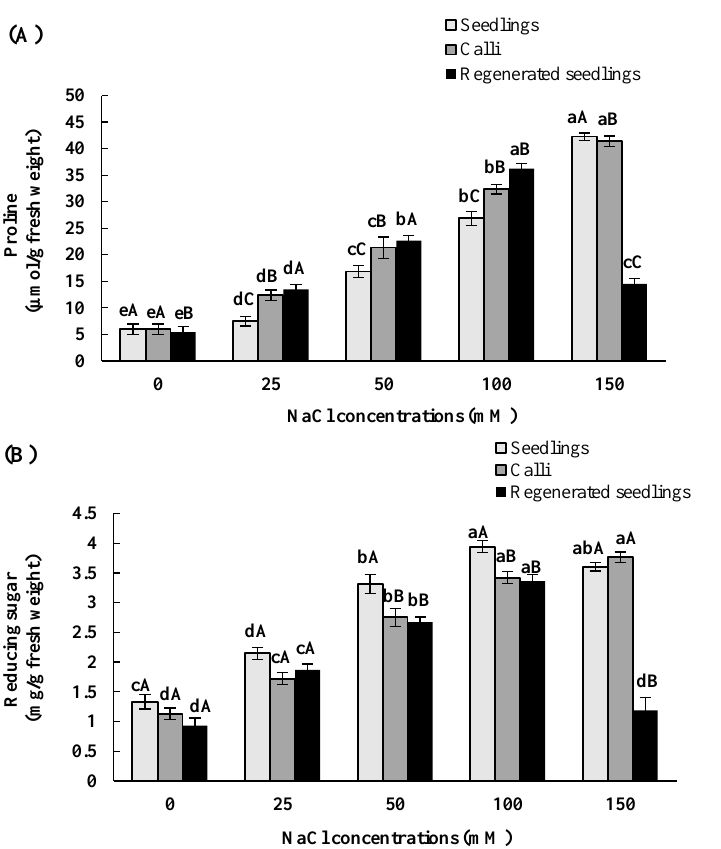
Figure 4. Effect of salinity on compatible osmolytes of Carum copticum. Mature sterilized seeds and regenerated seedlings were grown on MS medium containing 0, 25, 50, 100, and 150 mM NaCl. Calli were cultured on MS medium containing 1 mg L −1 BAP, 0.25 mg L −1 2,4-D, and the above-mentioned concentrations of NaCl. The amount of proline ( A ) and reducing sugars ( B ) were measured using four-week shoots of salt treatment. Values represent the mean of three replicates with error bars indicating ± standard errors. Different lowercase letters indicate significant differences among the 5 NaCl concentrations in an explant of Carum copticum, and different uppercase letters indicate significant differences among 3 explants of Carum copticum within the same NaCl level according to Duncan’s test p ≤ 0.05. Table 6. Comparison of proline and reducing sugar contents in three explants of Carum copticum under five NaCl concentrations.